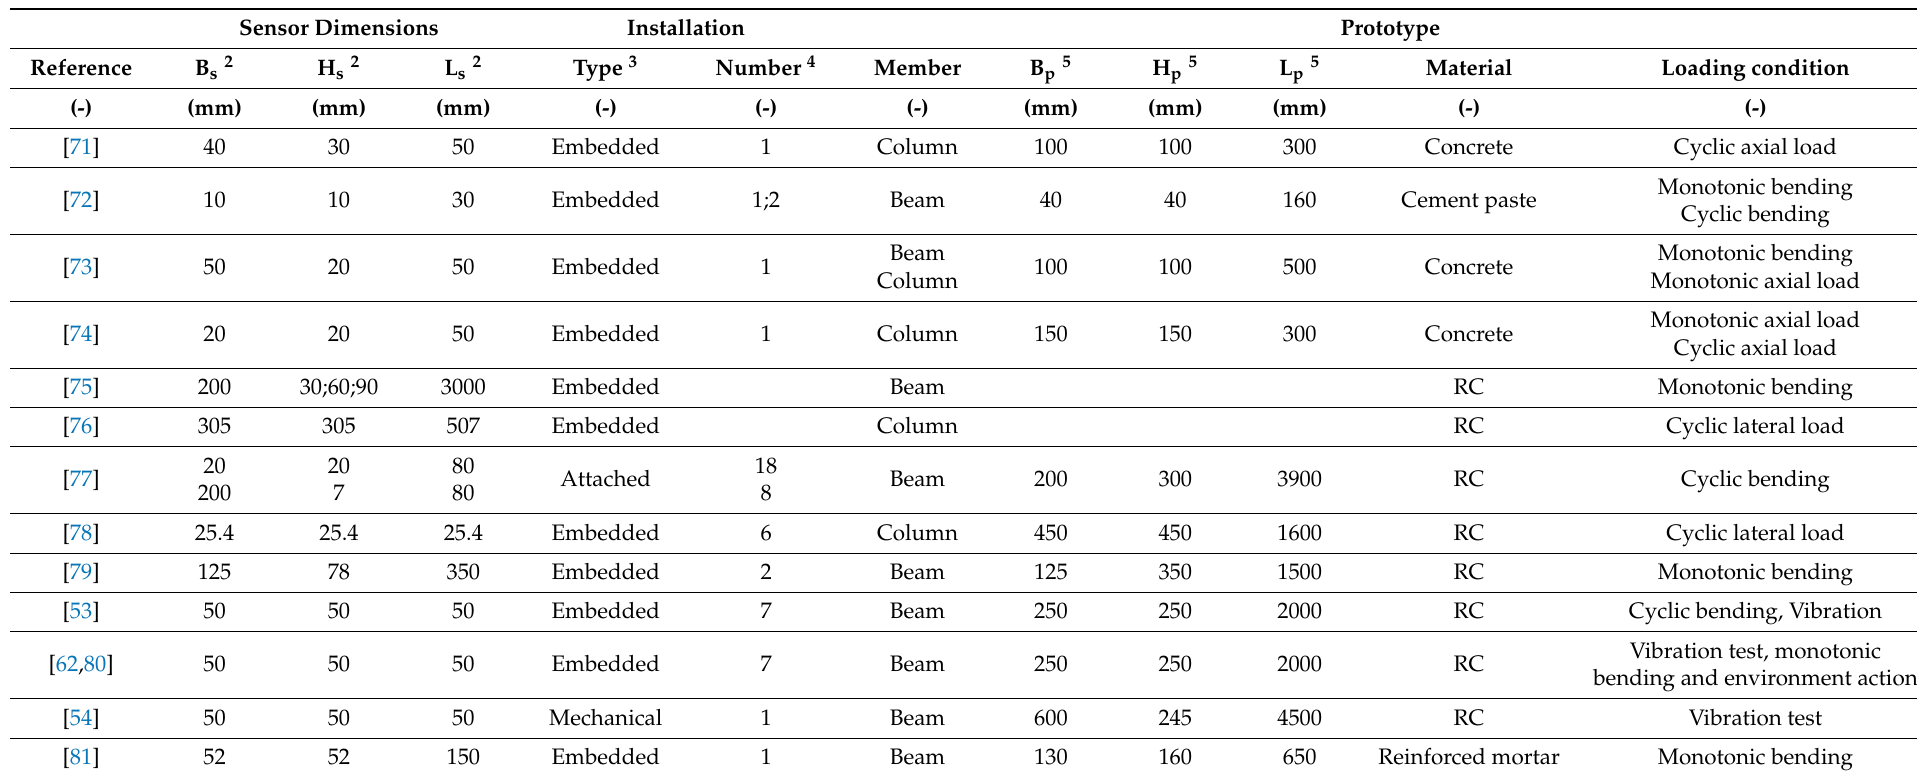
Table 2. Features of CSC sensors and structural prototypes tested for civil SHM purposes 1